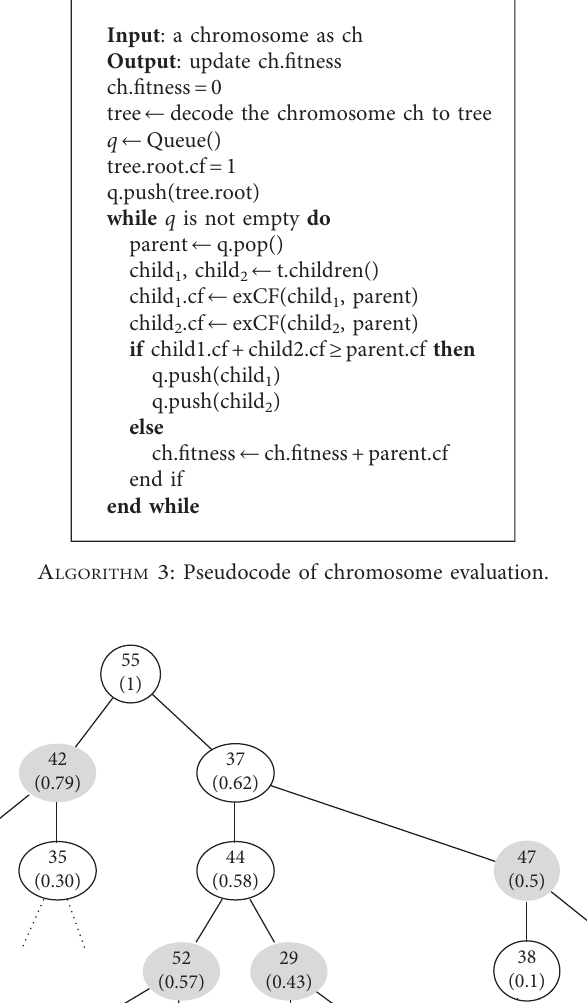
Figure 8: An example for crossover operation of TDHC.